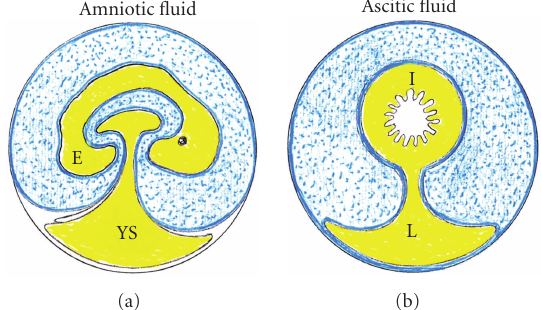
Figure 8: Comparative and schematic view of the amniotic egg and ascites in the decompensated portal hypertensive syndrome. Amniotic fluid circulates through the gastrointestinal tract of the embryo favoring its trophism and maturation. On the contrary, in the adult organism the proposed equivalent fluid, the ascitic fluid, is confined within peritoneal cavity. E: embryo; YS: yolk sac; I: intestine; L: